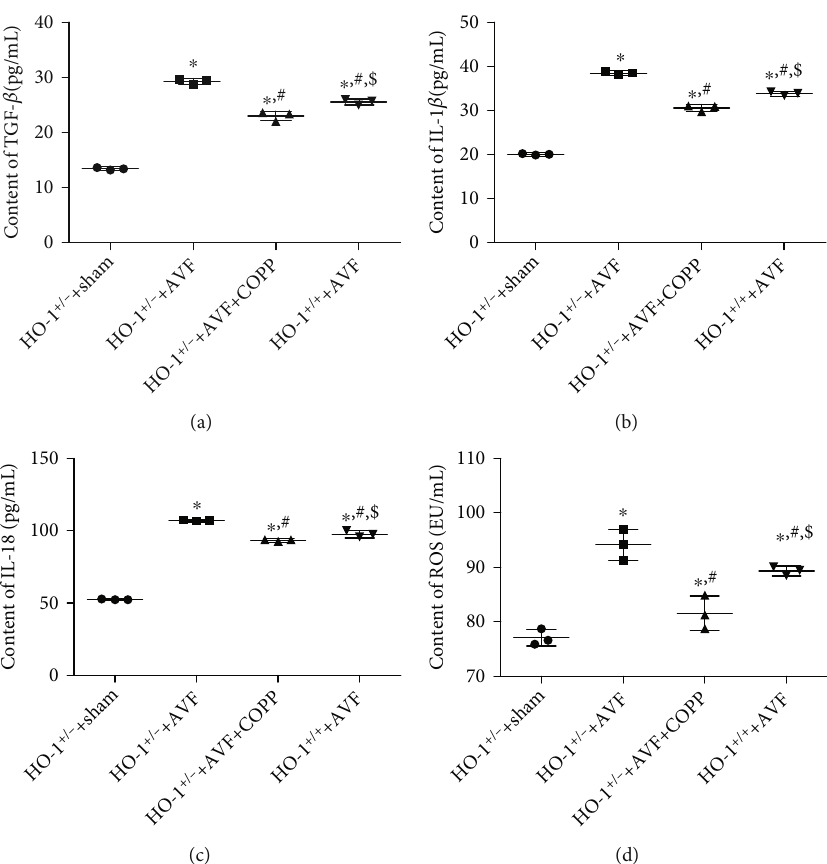
Figure 5: E ff ects of HO-1 knockdown on the levels of TGF- β , IL-1 β , IL-18, and reactive oxygen species (ROS). (a) The contents of TGF- β in di ff erent groups. (b) The contents of IL-1 β in di ff erent groups. (c) The contents of IL-18 in di ff erent groups. (d) The level of ROS in di ff erent groups. ∗ P < 0 : 05 , compared with the HO-1 +/- +sham group; # P < 0 : 05 , compared with the HO-1 +/- +AVF group; $ P < 0 : 05 , compared with the HO-1 +/- +AVF+COPP